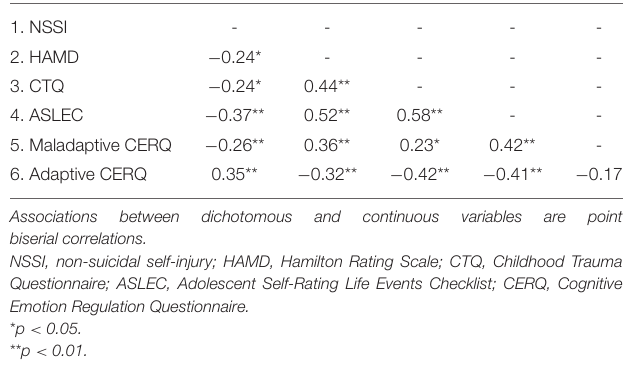
TABLE 3 | Correlation between childhood maltreatment, stressful life event, cognitive emotion regulation strategies, and depression.